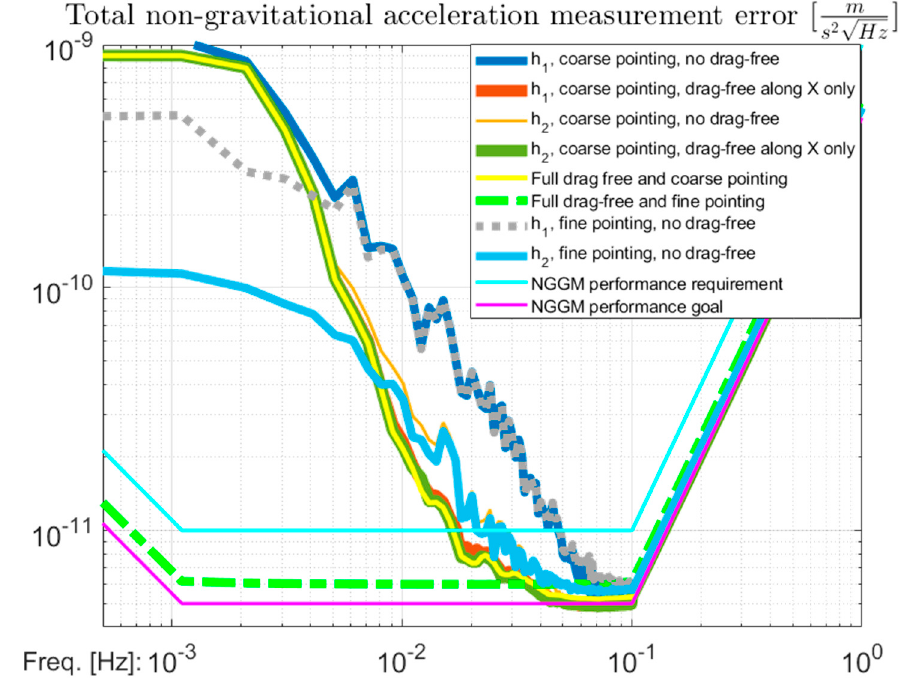
Figure 20. Performance for the scenarios with both coarse pointing and degraded drag-free per- formances at h 1 = 492 km and h 2 = 396 km, overlaid to the cases with full drag-free control at any altitude combined with fine and coarse pointing.